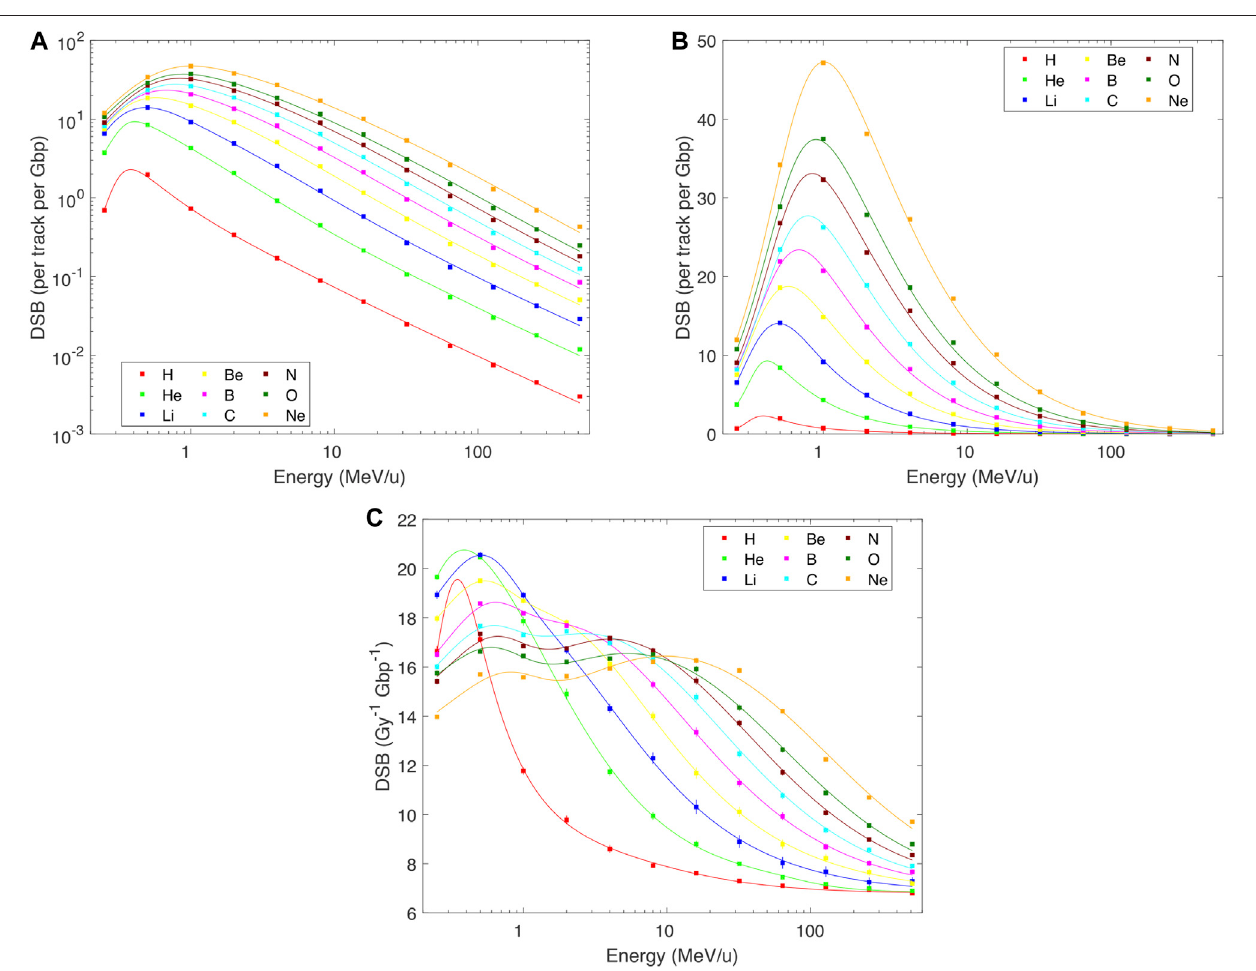
FIGURE 2 | PARTRAC simulations of the yields of DNA double-strand breaks (DSBs) in human lymphocytes by H – Ne ions with starting energies from 0.25 to 512 MeV/u (symbols), fi tted by analytical formulas (lines). Error bars depict estimated 95% con fi dence intervals of the simulated results. Where error bars are not visible, theyaresmallerthanthesymbols.Panels (A,B) :yieldspertrackperGbp,inlogarithmicandlinearscales,calculatedasaproductof Eqs1 and 2 ,detailsinthetext;panel C: yield per Gy per Gbp, in linear scale, fi tted by Eq. 2 with parameters in Table 2 .